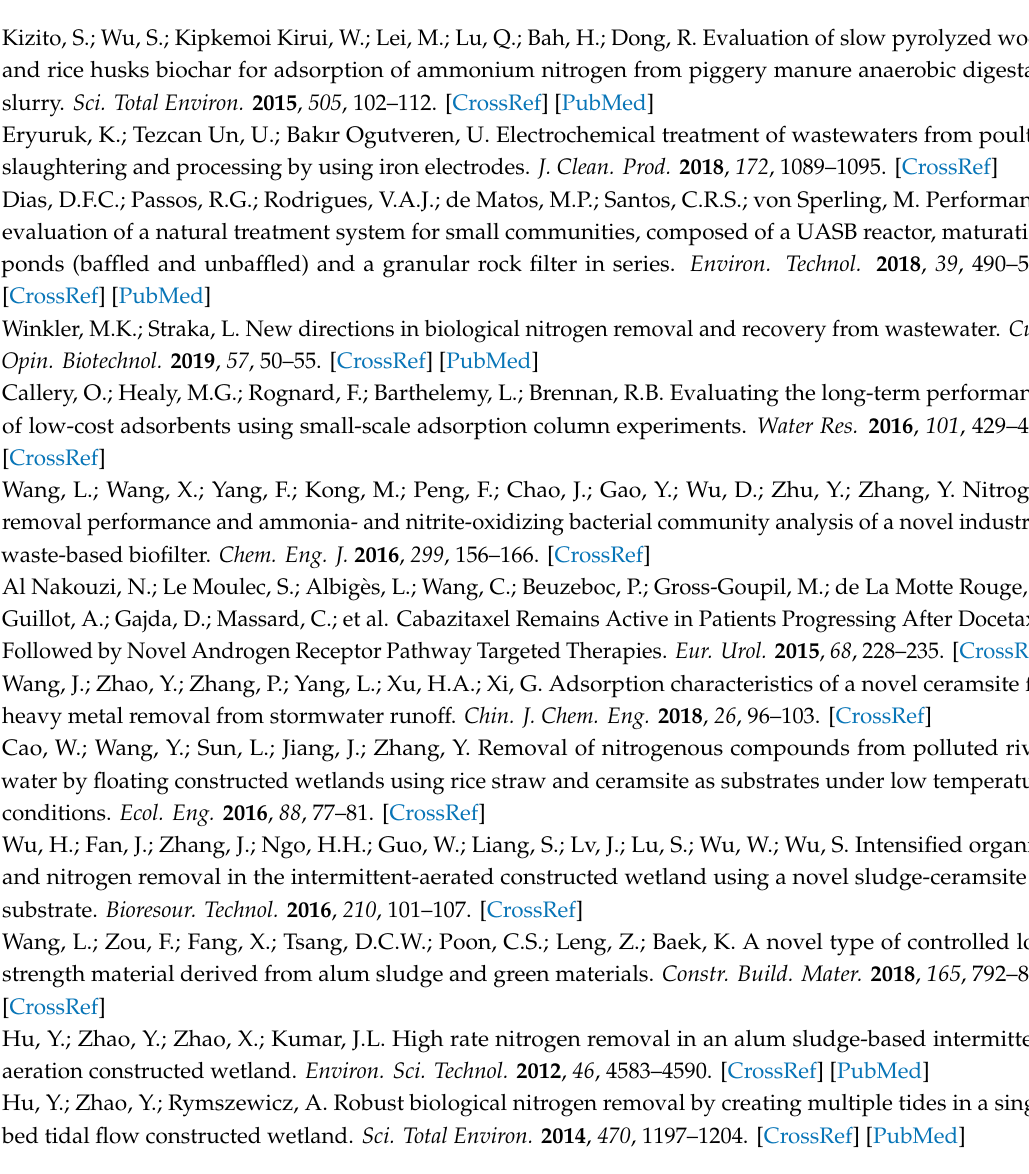
Table S1: Physicochemical properties of CFM and DAS material. Table S2: Chemical composition analysis of CFM and DAS material. Table S3: Specific primer sequence of HTR and PCR amplification cycle condition. Table S4: Environment indicators of di ff erent